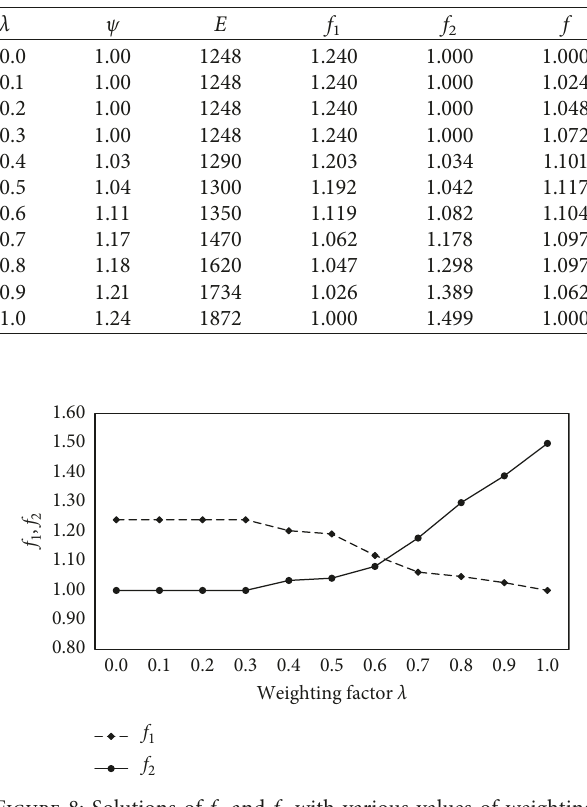
Table 5: The ψ , E , and corresponding function values for Test Network-2.